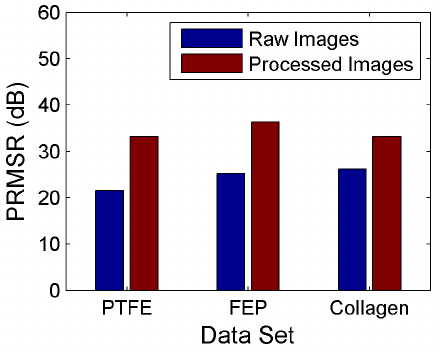
Figure 5. Comparison of image signal-to-noise ratio before and after image preprocessing. The mean SNR of all images ( . 2000) is plotted for each data set.